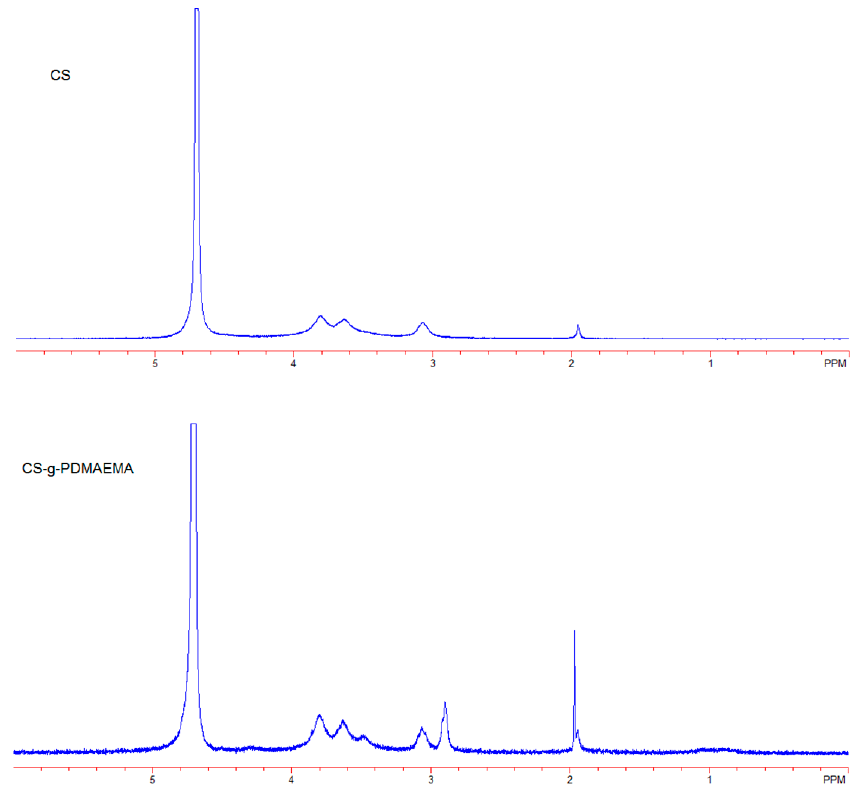
Figure 4. 1 H-NMR spectra of CS and CS- g -PDMAEMA.